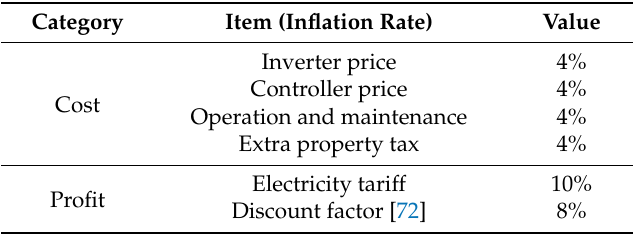
Table 13. Economic